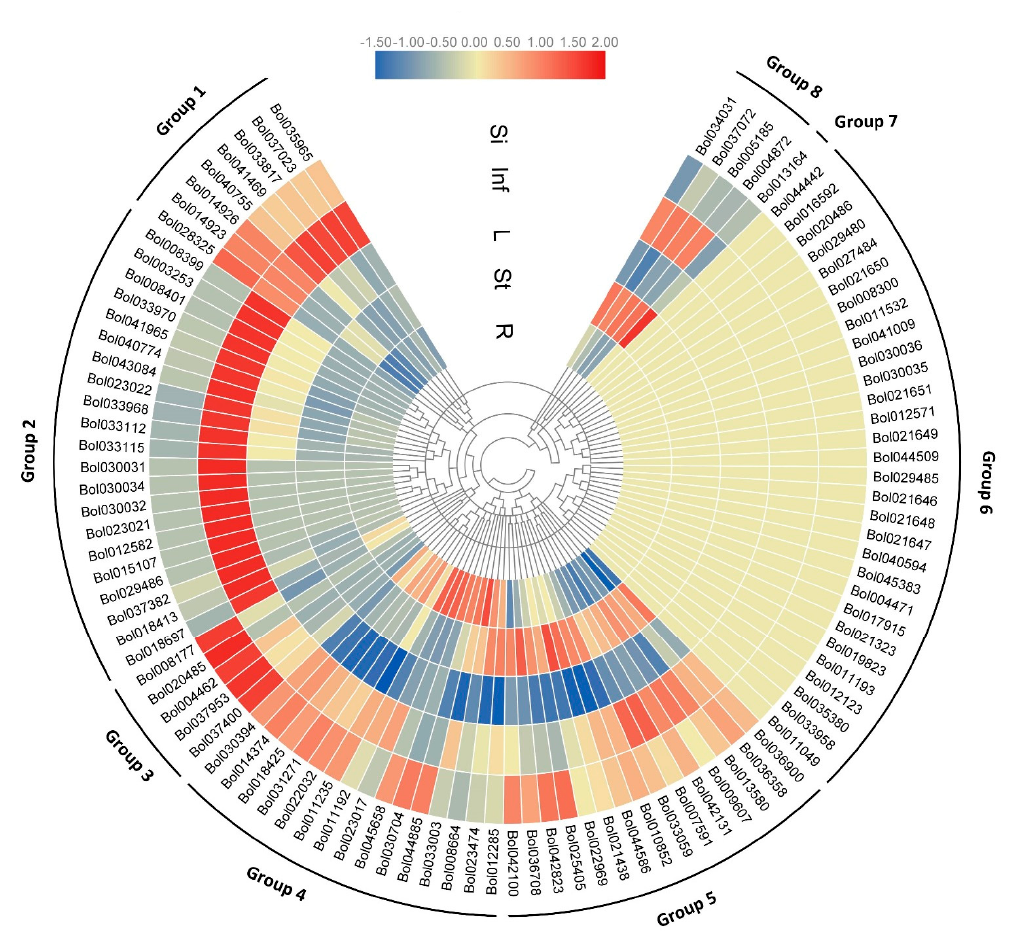
Figure 5. Hierarchical clustering and heatmap showing the expression levels of BoPGs. The scale bars represent the relative expression level. The blue, yellow, and red shading indicates a relatively low, medium, and high expression, respectively. Their expression characteristics are divided into eight groups. R: roots; St: stems; L: leaves; Inf: inflorescences; and Si: tender